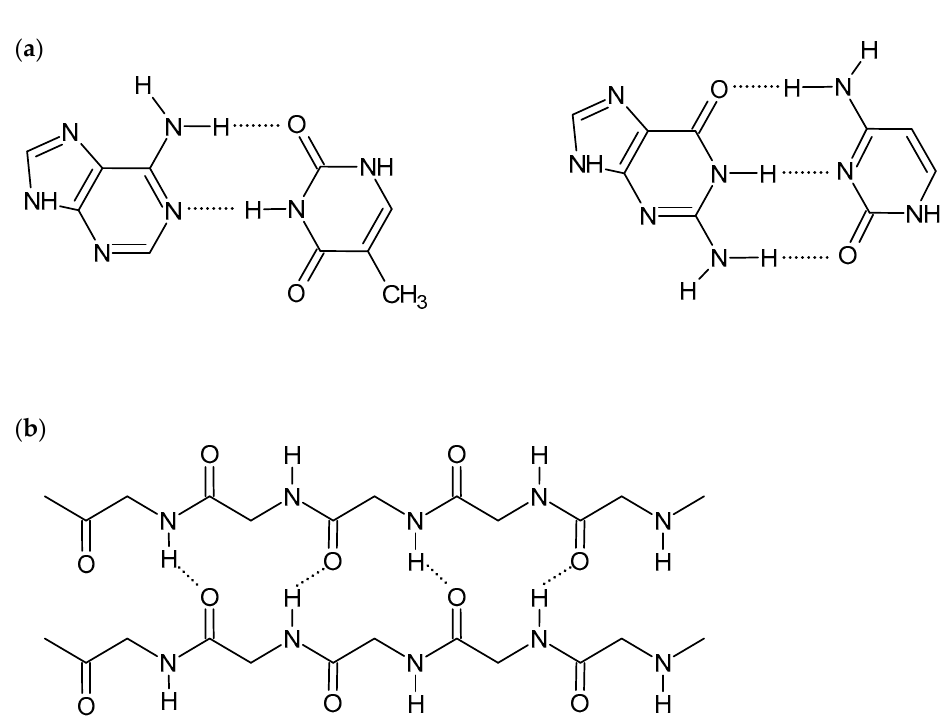
Figure 1. Scheme of hydrogen bonds between: ( a ) DNA base pairs, ( b ) proteins ꞵ -sheet structure. Various compounds are used to create hydrogels stabilized by hydrogen bonds.